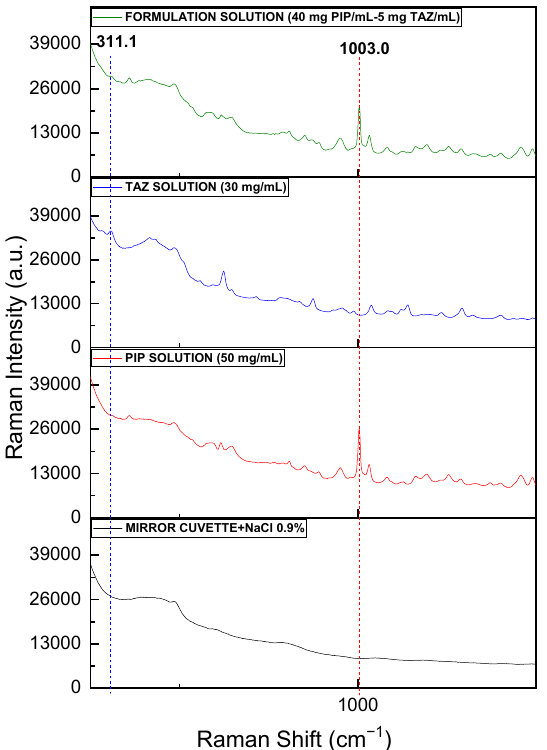
Figure 8. Raman spectra for solutions of pure PIP (50 mg/mL), pure TAZ (30 mg/mL), and the formulation (40.00 mg PIP/mL and 5.00 mg TAZ/mL), after the samples had been placed in the optic cell, as well as the blank sample spectrum (cell + NaCl 0.9%). PIP peak at 1003 cm − 1 is highlighted by the red dashed line, whereas TAZ peak at 311 cm − 1 is at the blue one.